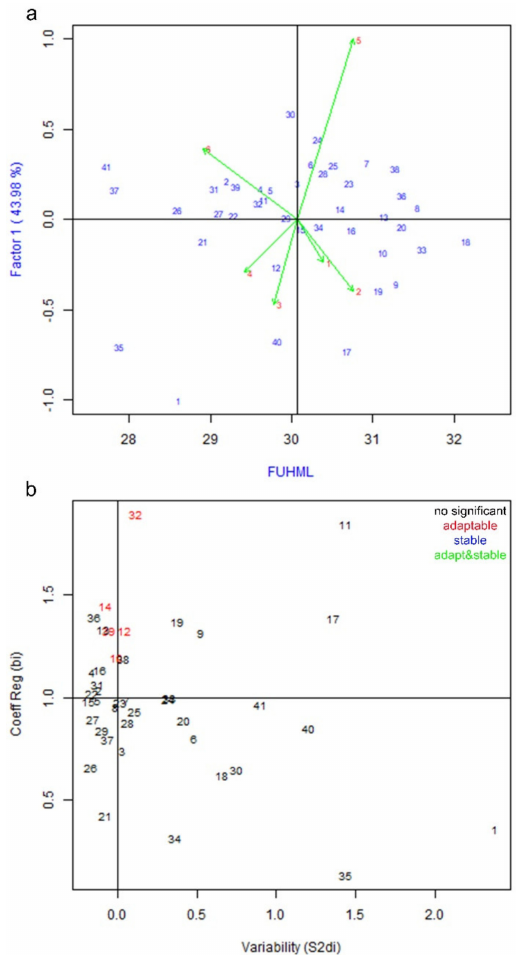
Figure 4. Mean performance and stability of 41 genotypes in six environments for fiber upper half mean length (FUHML). ( a ) Represents the mean of FUHML (mm) on the X-axis and first interaction principal component (IPC1) scores of GEI on the Y-axis. Blue and red colored numbers inside the biplot show genotypes and environments, respectively. ( b ) Shows stability analysis of FUHML, coe ffi cient of variability (X-axis) and coe ffi cient of regression (Y-axis). All numbers inside the biplot show genotypes. See Tables 1 and 2 for code description of genotypes and environments,